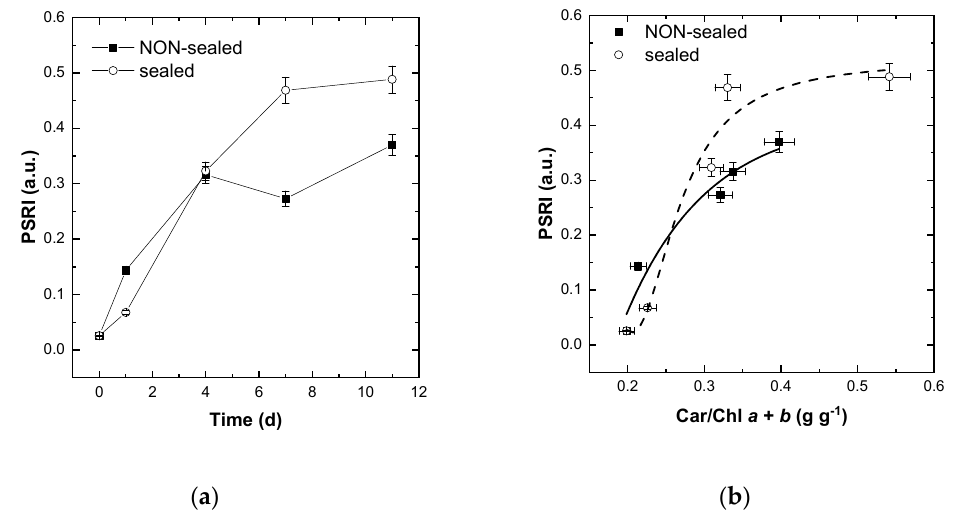
Figure 8. Changes in the average values of the indicative of leaf tissue senescence index PSRI during ( a ) storage of and ( b ) decline of [Chl] (indicative of leaf discoloration) in the stored non-sealed (closed symbols) and sealed (open symbols) fresh-cut lettuce leaves. See also Figures S4 and S5.